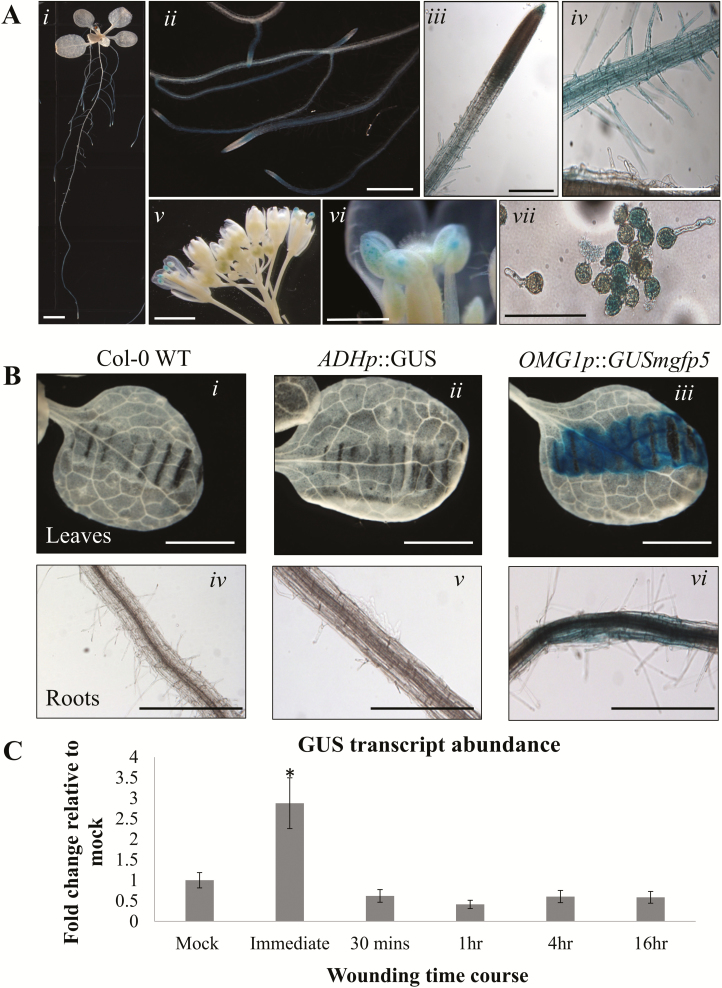
A transgenic reporter line OMG1 promoter::GusGFP in the WS ecotype background shows OMG1 5′ flanking region activity. (A) Transgenic Arabidopsis plants of various ages underwent histochemical GUS staining with X-Gluc. The images show representative distribution patterns of GUS staining in (i) maturation zone of roots, (ii–iii) lateral roots, (iv) root hairs of the maturation zone, (v–vii) pollen and pollen tubes. Scale bars: (i–ii) 1 mm; (iii–vii) 100 µm. (B) OMG1 5′ flanking region activity was also observed upon wounding with a pair of forceps. Wild-type (WT) Col-0, Adh promoter::Gus transgenic line were used as a control to ensure GUS enzymatic activity was specific for OMG1 5′ flanking region. Both leaf (i–iii) and root tissue (iv–vi) from the various lines were used. Scale bars: 100 µm. (C) Intact leaf tissues were wounded and left for the allotted times before they were harvested for qRT-PCR analysis. The GUS transcript abundance fold change relative to mock was done to access the rapid wounding response of OMG1 5′ flanking region. All error bars represent the standard error of the mean (SEM) of triplicate representative experiments. * indicate significant (P < 0.05) difference between immediate and the various wounding time points by doing a single-factor ANOVA followed by post hoc Student’s t-test with Bonferroni correction.